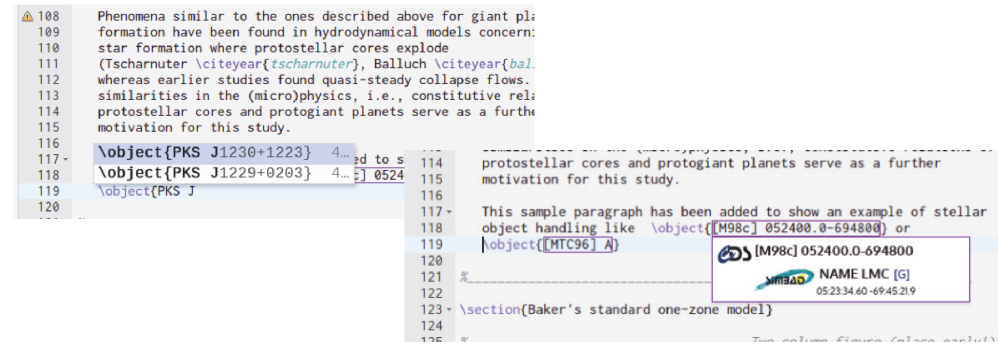
Figure 4. Links to stellar